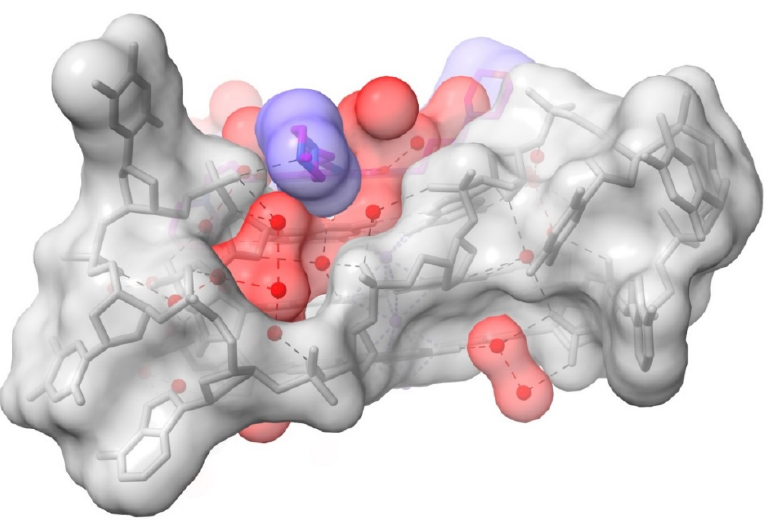
Figure 3. Surface representation of a view into groove 2 in the 3UYH complex. The N-methyl- piperazine substituent of MM41 is oriented end-on and is colored blue. Note that the groove space is filled out by water molecules, colored red. The semi-transparent surface of the G-quadruplex is colored grey.